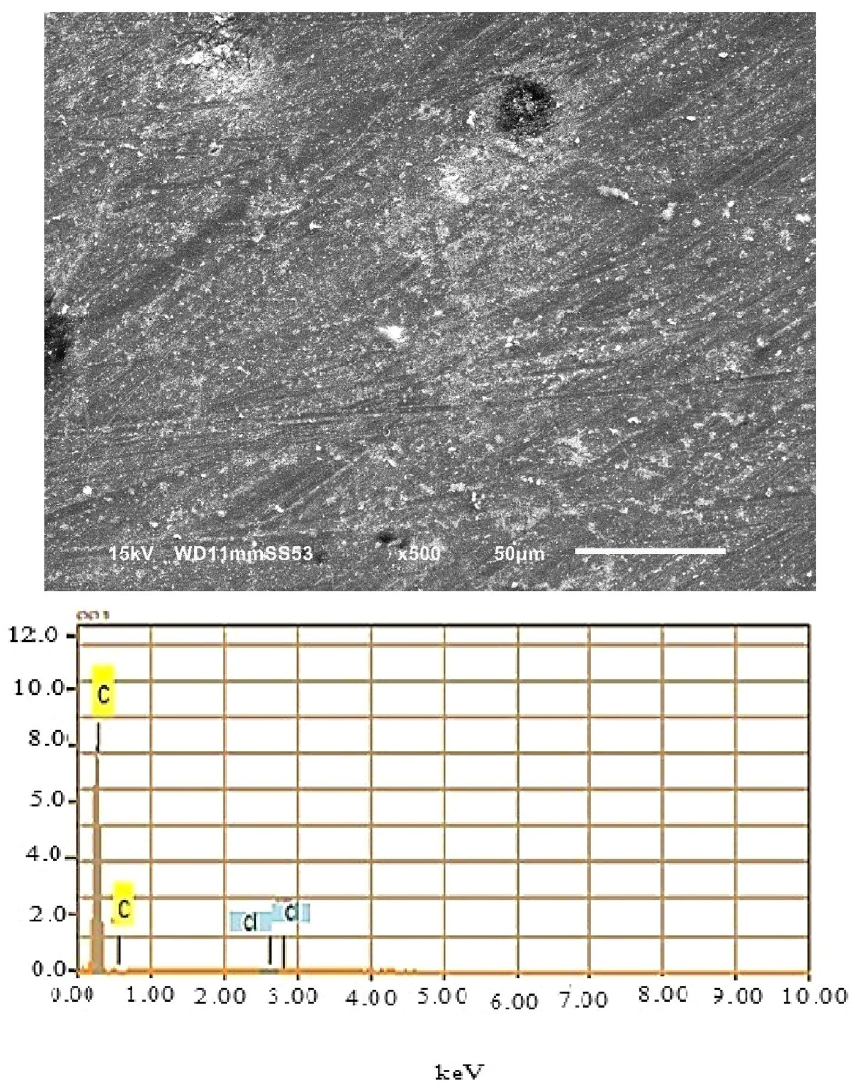
Figure 11. SEM analysis along with EDX of coated heat affected